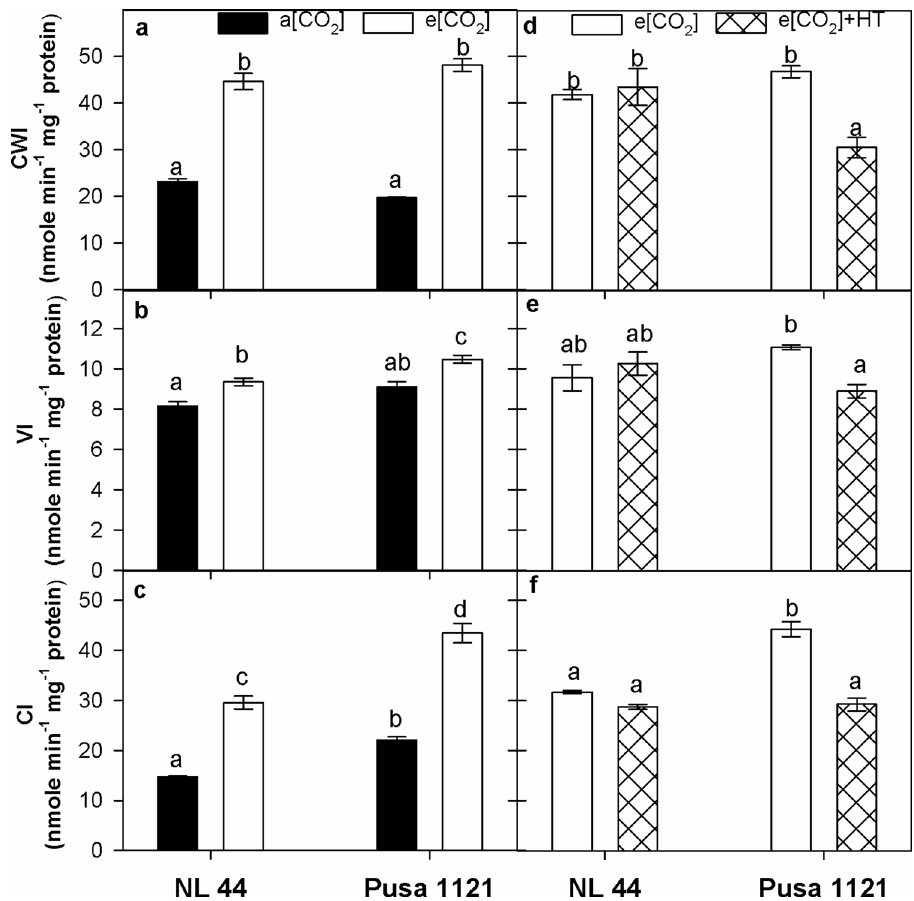
Figure 3. Cell wall invertase ( a , d ), vacuolar invertase ( b , e ) and cytosolic invertase ( c , f ) activity in spikelets of rice cultivars NL-44 and Pusa 1121 at 10 days post 100% flowering (10 DPF) under ambient and